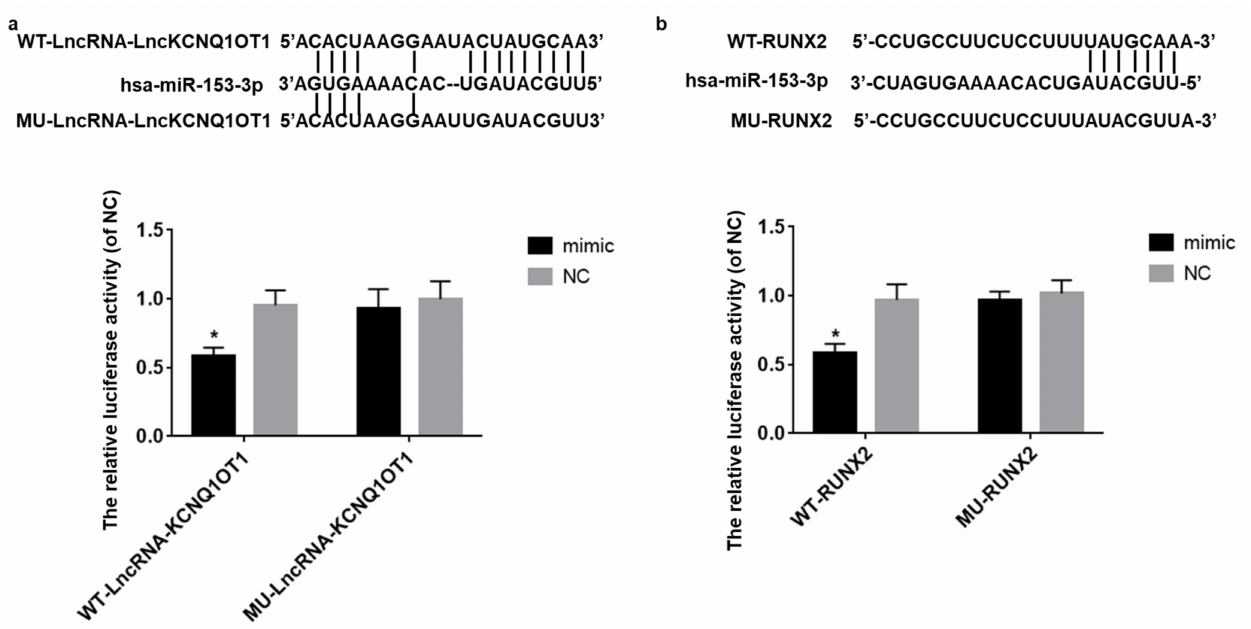
Figure 4. LncKCNQ1OT1 act as a sponge of hsa-miR-153-3p and hsa-miR-153-3p target on RUNX2. ( a ) In the WT-LncKCNQ1OT1 reporter gene system, the relative activity of luciferase in mimic group was significantly lower than that in NC group. When the binding fragment of LncKCNQ1OT1 was mutated, the luciferase relative activity of mimic group was similar to the NC group. ( b ) In the WT-RUNX2 reporter gene system, the relative activity of luciferase in mimic group was significantly lower than that in NC group. When the core sequence of 3 (cid:48) UTR of RUNX2 was mutated, the luciferase relative activity of mimic group was similar to the NC group. * vs. NC group, p <